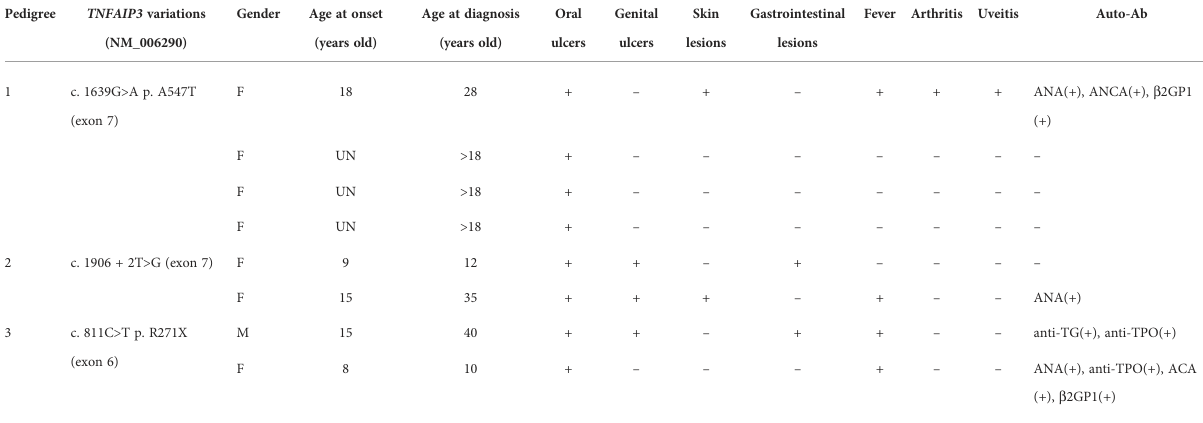
TABLE 1 Clinical manifestations of three Chinese pedigrees of A20 haploinsuf fi ciency. Pedigree TNFAIP3